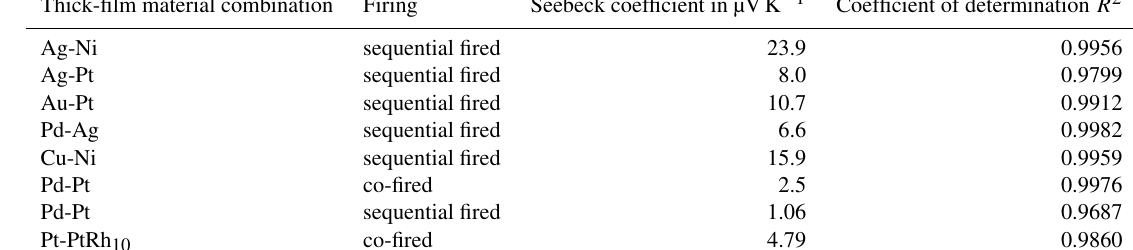
Table 1. Calculated Seebeck coefficients of different thick-film thermocouple combinations in the temperature range 50–300 ◦ C. Thick-film material combination